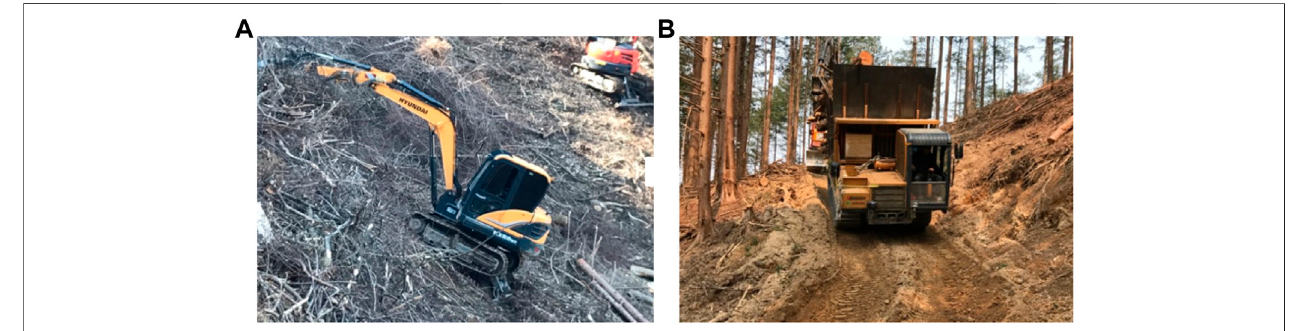
FIGURE 2 | Typical extraction team. (A) Small-shovel loader (5.0 ton steel track excavator with log grapple) for log extraction on skid trails and (B) carrier (MST800VDL; Morooka Co., Ltd., Ryuugasaki, Ibaraki, Japan) for log transportation to landing areas.